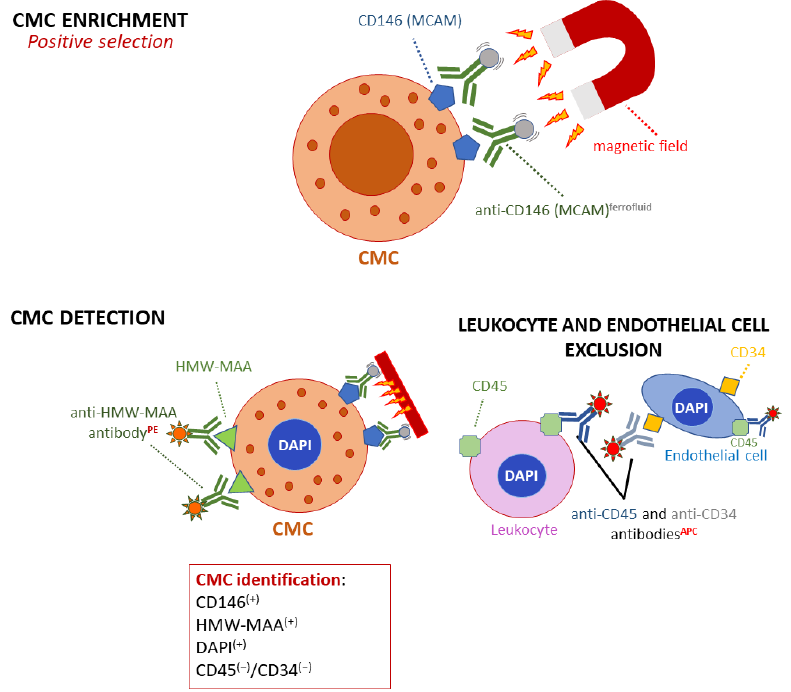
Figure 3. CellSearch ® strategy to enrich and detect CMCs in patients with a melanoma. The positive CMC enrichment is based on the expression of CD146 by melanoma cells. Subsequently, CMC detection is based on the expression of the high molecular weight melanoma-associated antigen, as well as the presence of a nucleus (visualized using DAPI). The exclusion markers are (i) CD45, specific for leukocytes and some endothelial cells and (ii) CD34, expressed by endothelial cells. As endothelial cells also express CD146, CD34 is important to consider to discriminate these cells from CMCs that are CD34 ( − ) . Abbreviation: MCAM, melanoma cell adhesion molecule; HMW-MAA, high molecular weight; PE, phycoerythrin; APC,